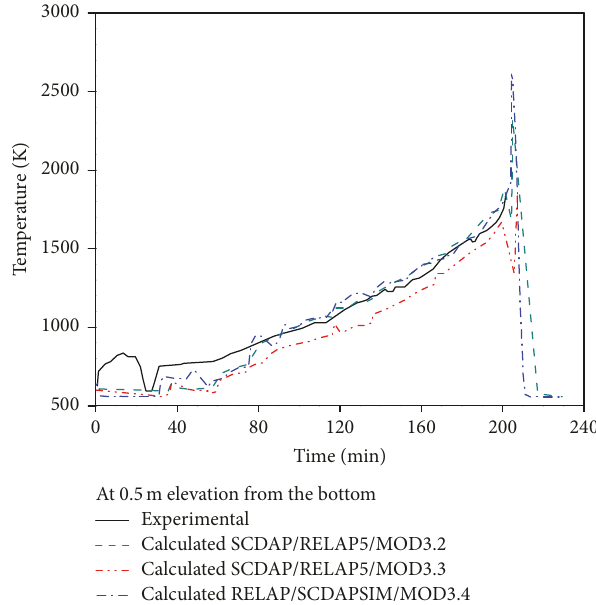
Figure 7: Comparison of measured and calculated cladding tem- peratures at 0.35 m elevation. Figure 8: Comparison of measured and calculated cladding tem- peratures at 0.5 m